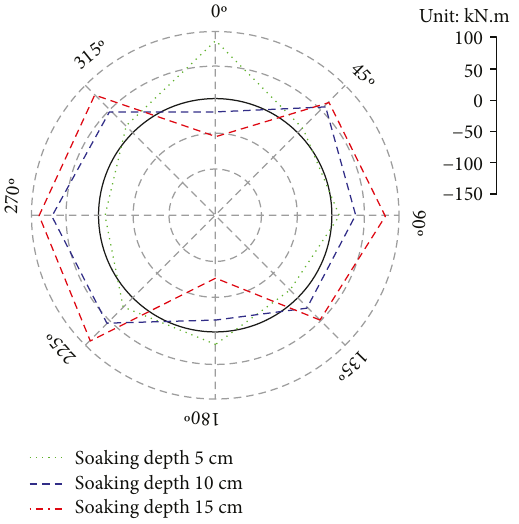
Figure 15: Bending moment of full-range soaking in fi nal